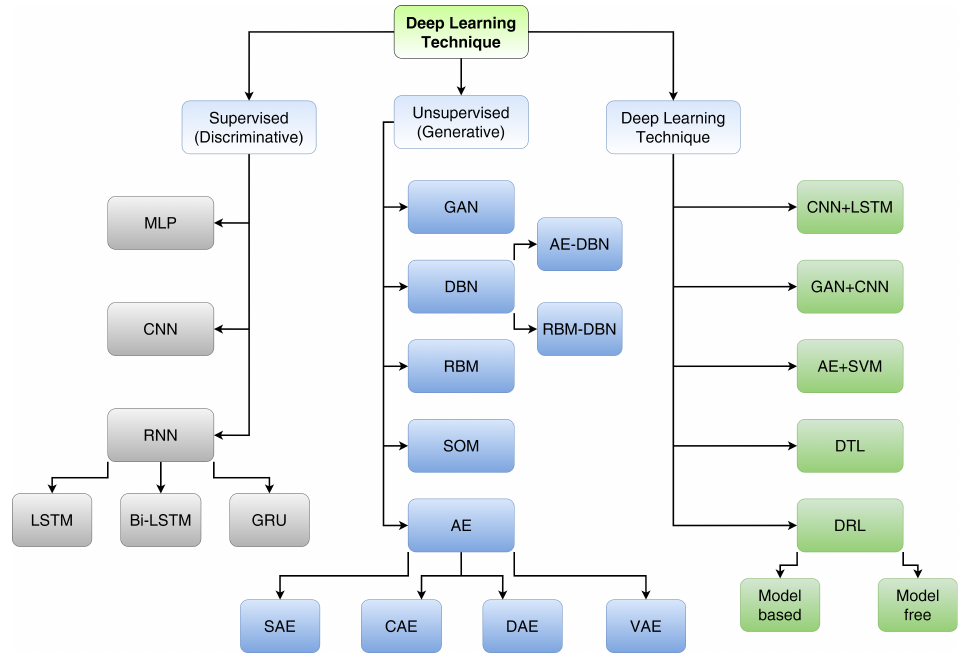
Figure 16. A taxonomy of DL techniques. For acronyms, see main